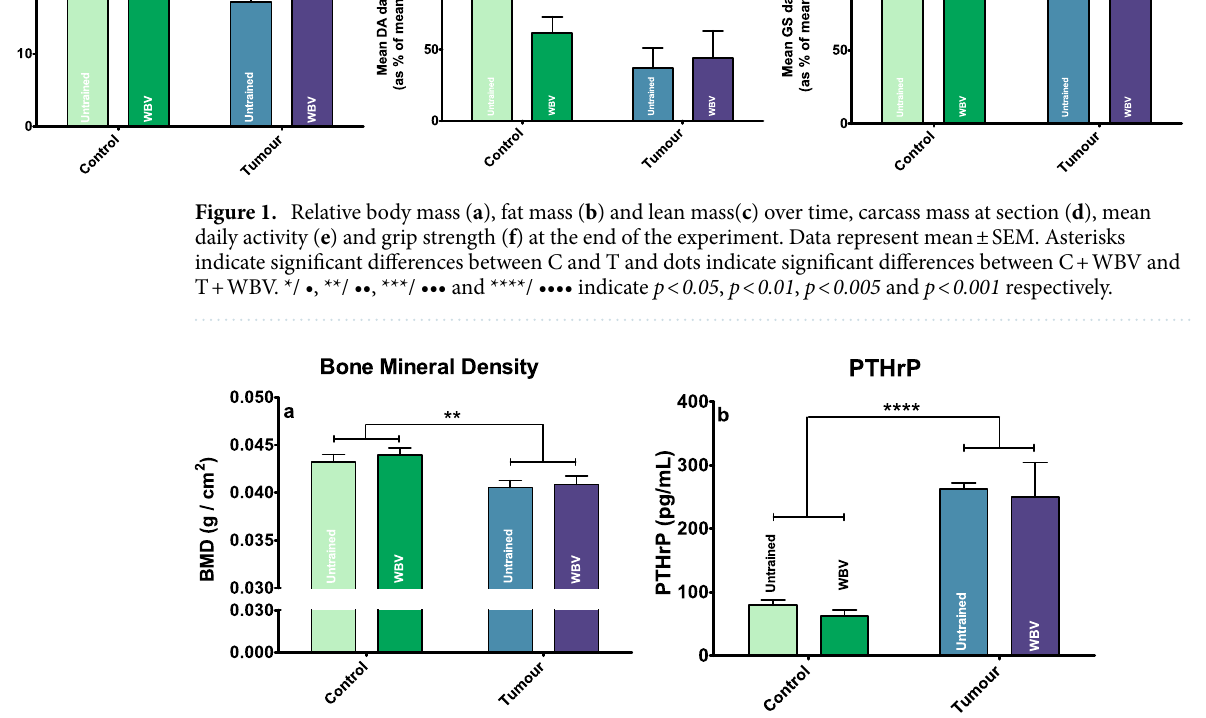
force-frequency and the exercise protocol was significantly lower in the T and T + WBV groups (Fig. 4b,c). In the rate of force development, no differences were found (Fig. 4f).